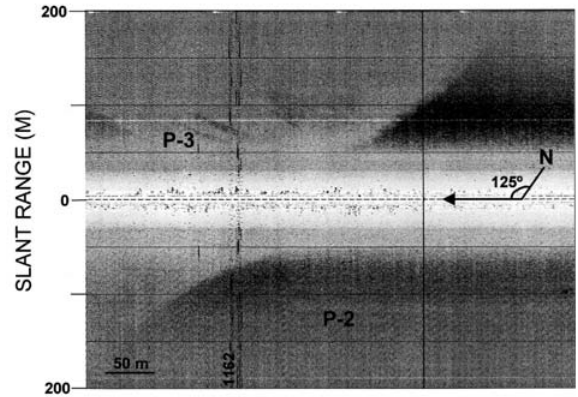
F IG . 7. – Sonograph showing a sharp boundary between both, pat- tern of strong backscatter (P-2) in dark grey (coarse sand to gravel) and pattern of weak backscatter (P-3) in light grey (fine grained sand and mud). See Fig. 4 for location.